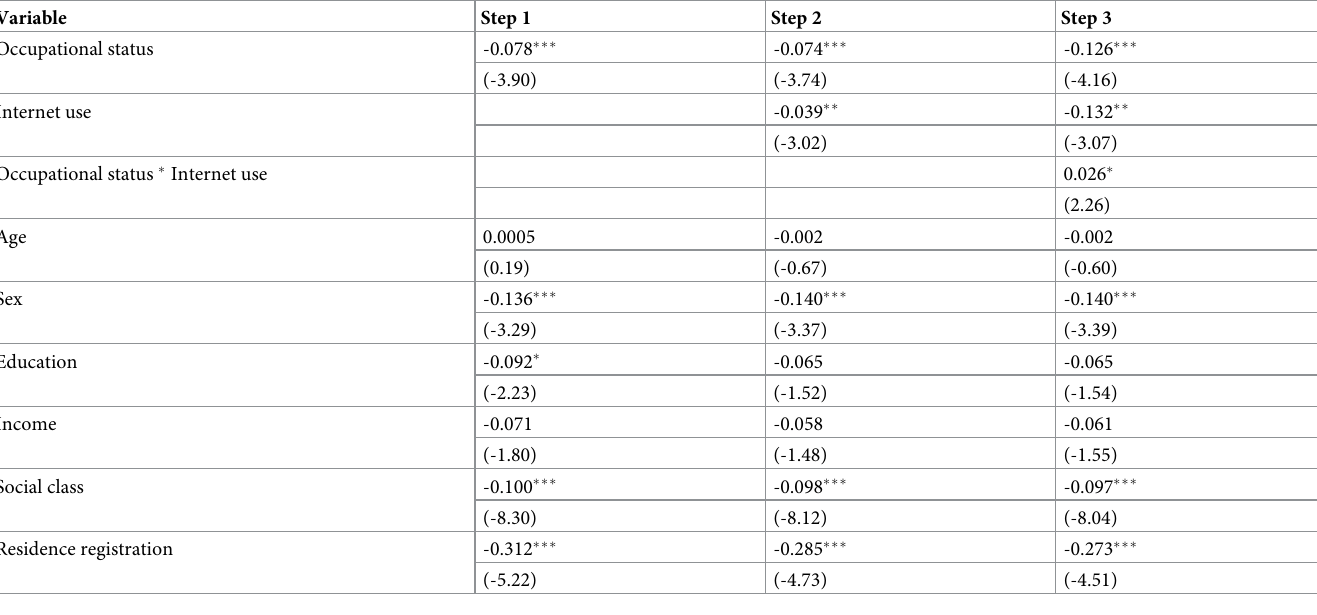
Table 2. Hierarchical regression results (N = 2,403).